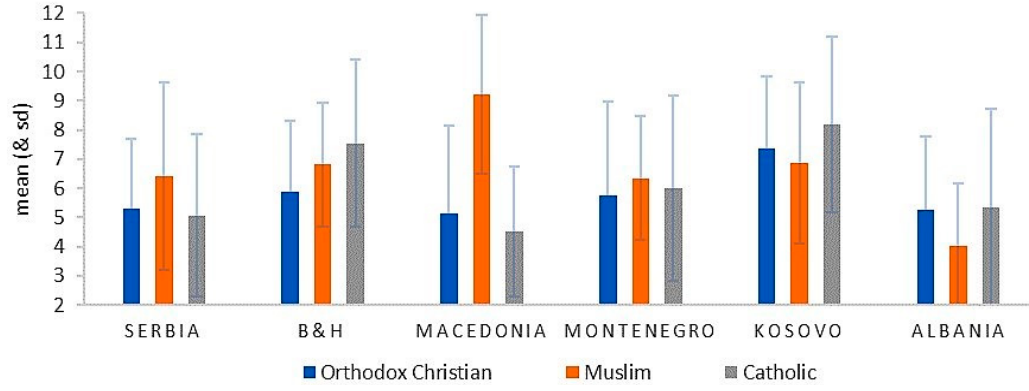
Figure 7. Level of religiosity by confession and country. (The error bars represent standard deviation).